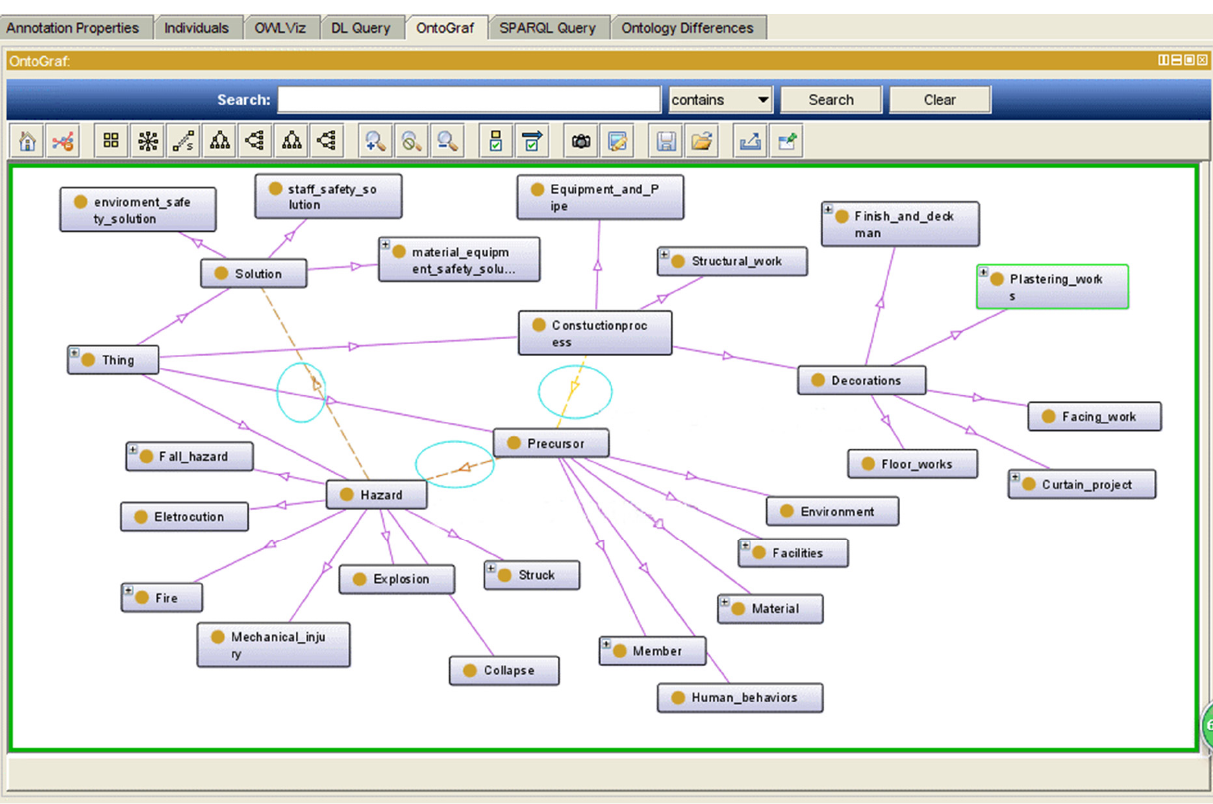
Figure 3. Class and class hierarchy relationship OntoGraf view.